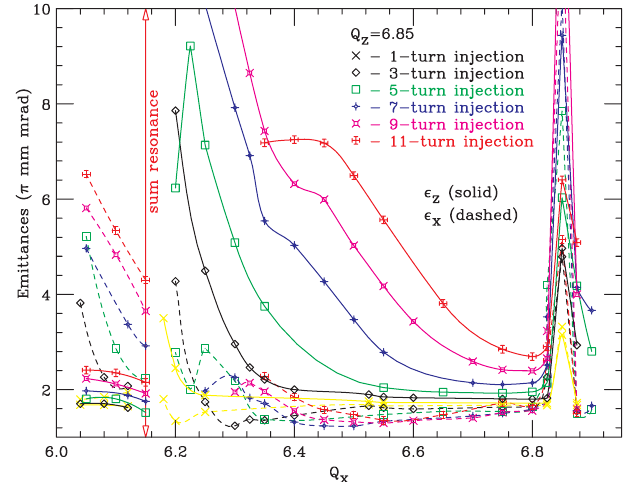
FIG. 34. (Color) The horizontal (dashed line) and vertical (solid line) emittances are plotted as a function of the horizontal tune for different beam intensities (from 1-turn to 11-turn